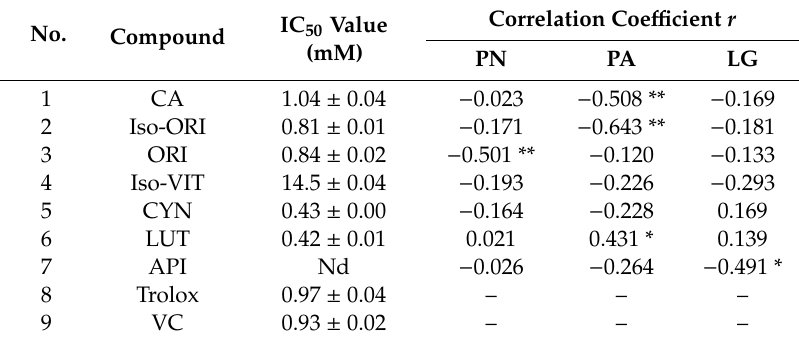
Table 5. The antioxidant IC 50 values of compounds and the correlations between contents and IC 50 values of